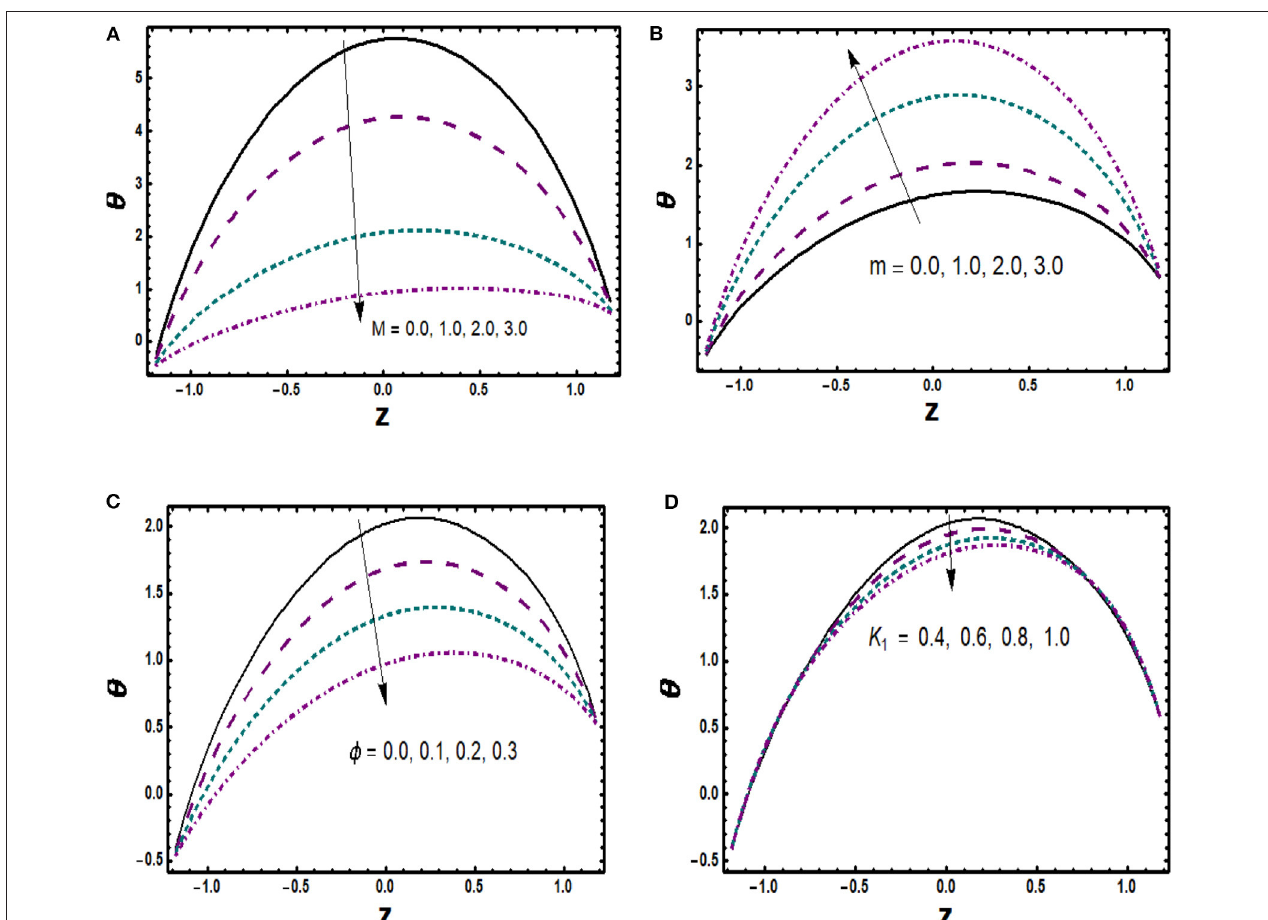
FIGURE 7 | (A–D) Effects of M, m, φ , and K 1 on θ ( z ) .